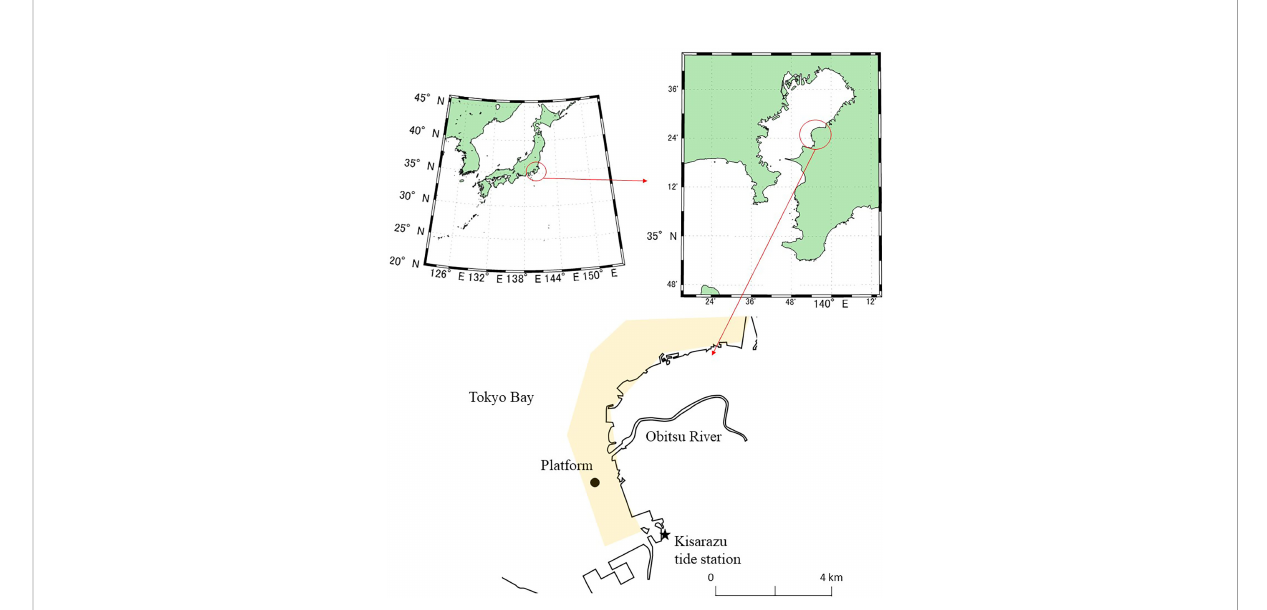
FIGURE 1 Location of the measurement site (Banzu tidal fl at, Tokyo Bay, Japan). The yellow shading indicates the area of the tidal fl at during low